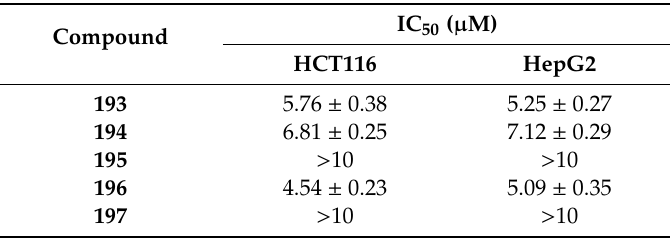
Table 28. Antiproliferative activity of 193 – 197 against human colon carcinoma cells HCT116 and human hepatocellular liver carcinoma cells HepG2.